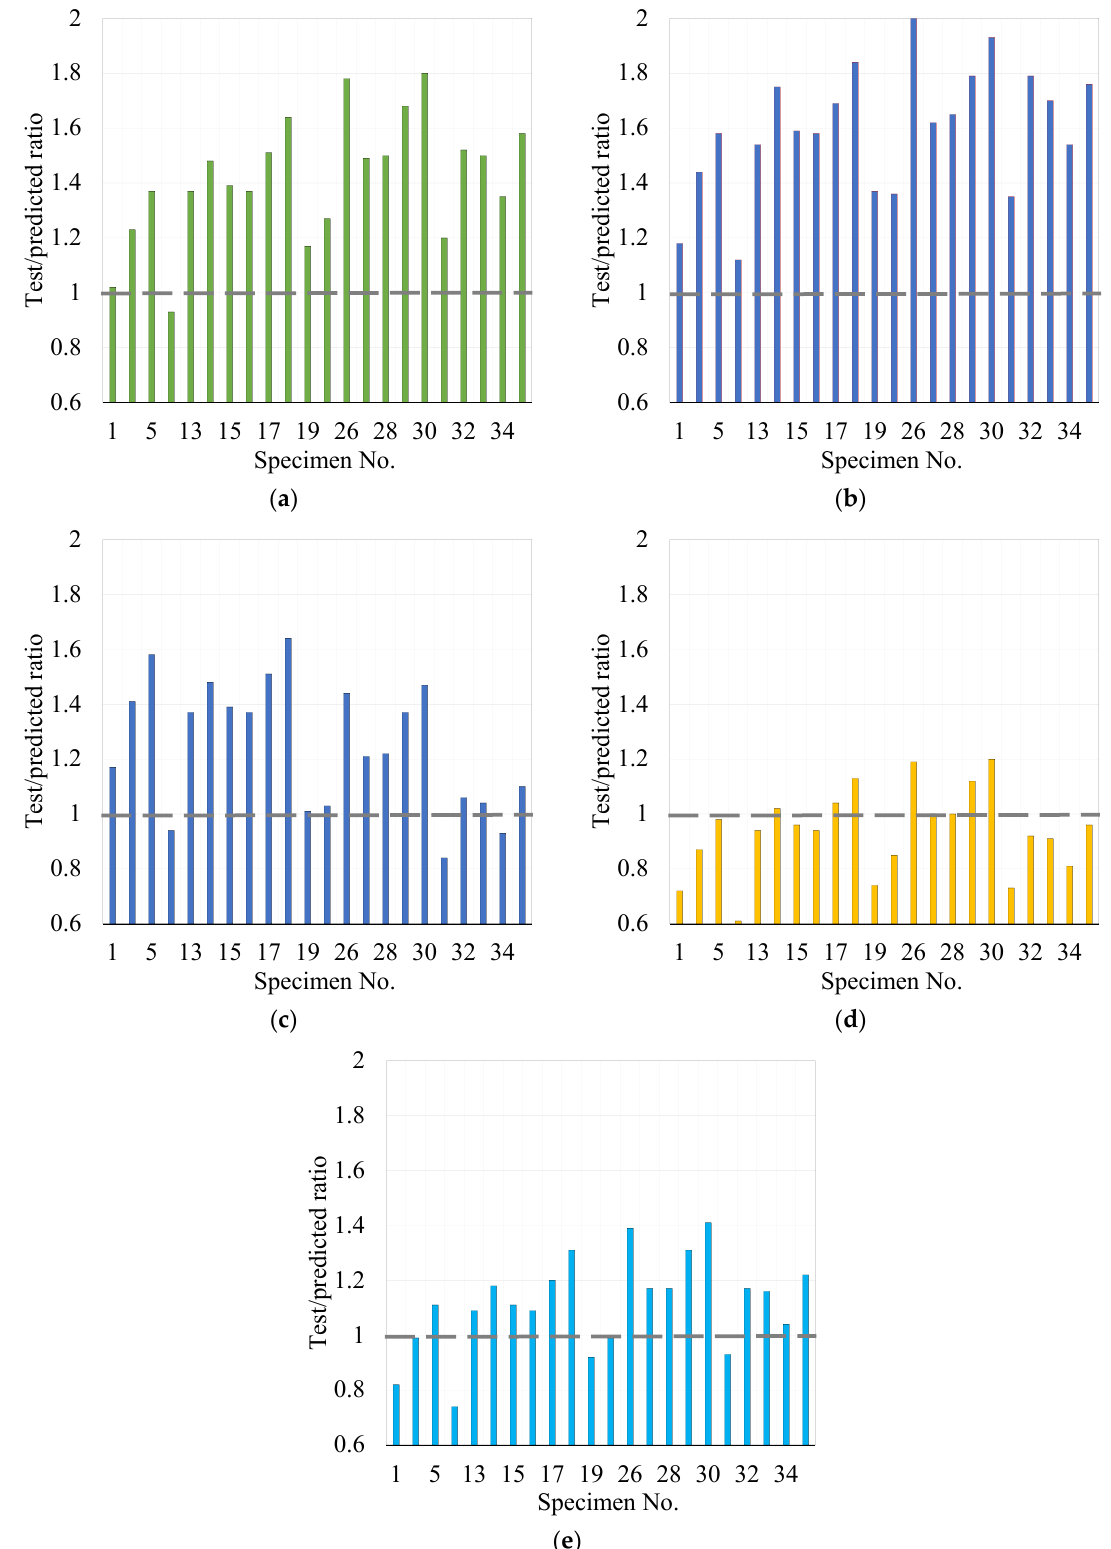
Figure 13. Bond stress test results/prediction ratios versus the specimen number (Table 7): ( a ) Orangun et al. [3]; ( b ) ACI committee 408R [2]; ( c ) Hadi [13]; ( d ) Esfahani and Rangan [6]; ( e ) Chapman and Shah [14].